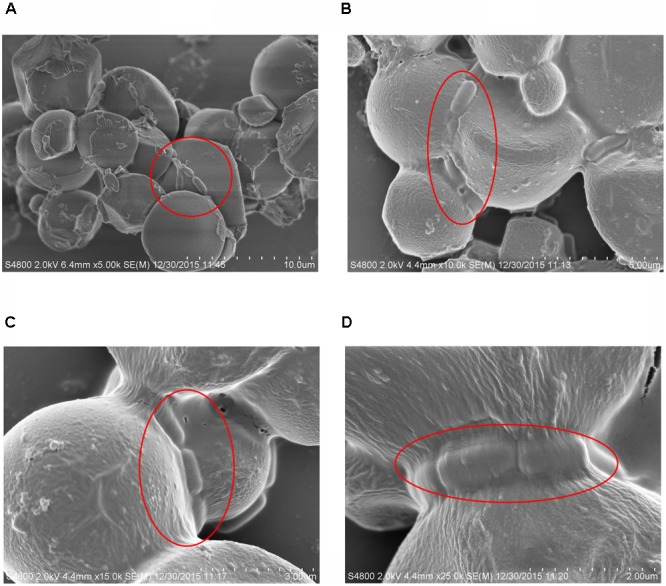
Scanning electron micrograph (SEM) of starch granules with the adhering L. paracasei subsp. paracasei L1 cells. (A) 5,000×; (B) 1,000×; (C) 15,000×; (D) 25,000×.